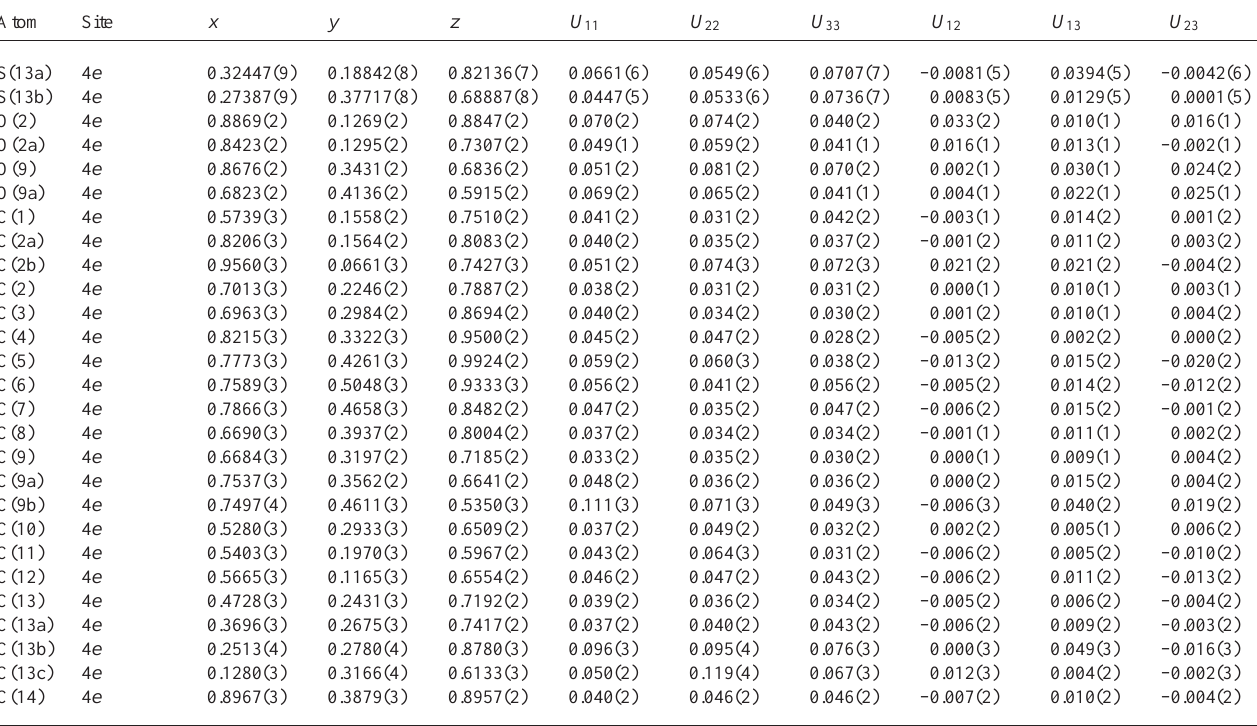
Table 3. Atomic coordinates and displacement parameters (in Å 2 )